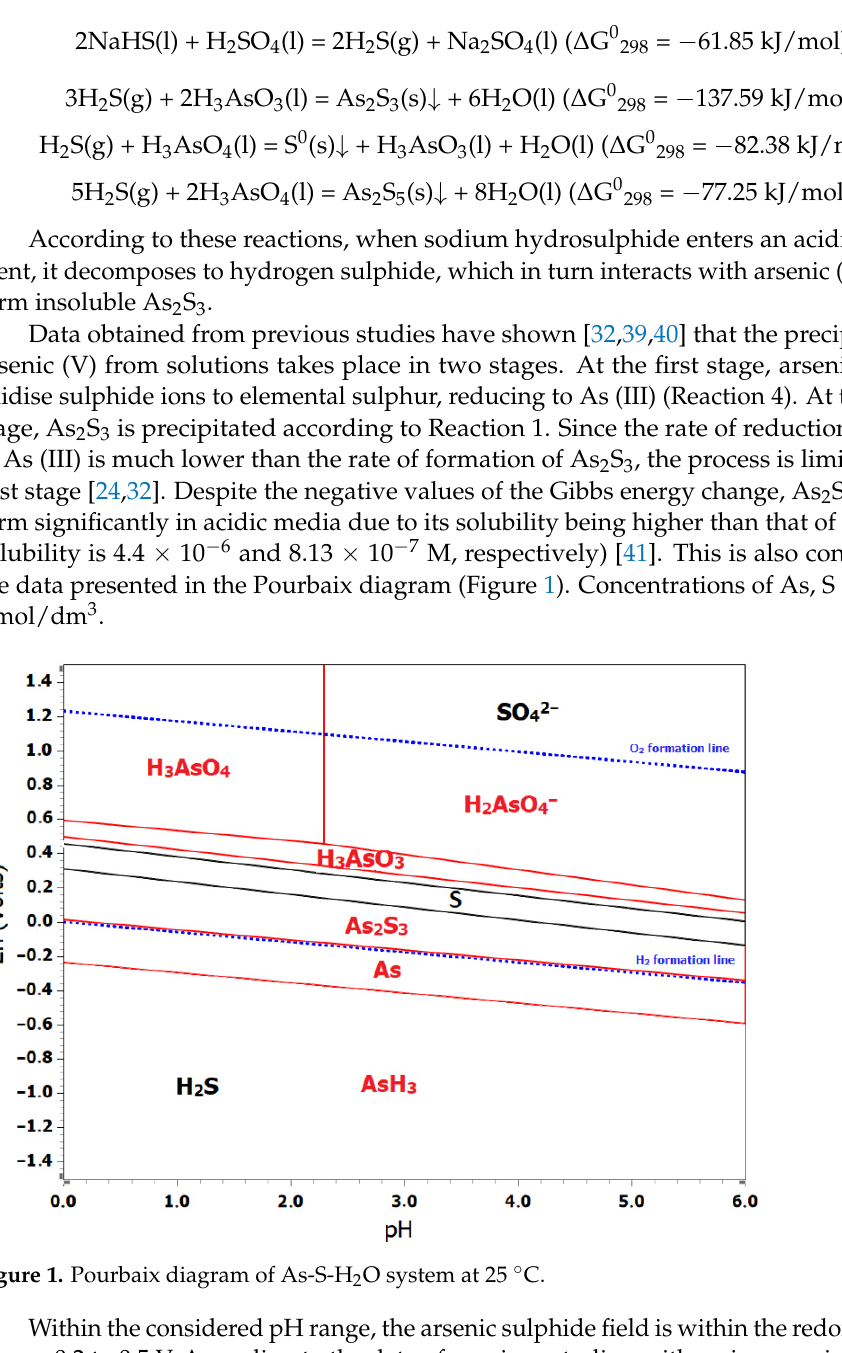
from 0 to 1.1 V at pH from 0 to 6